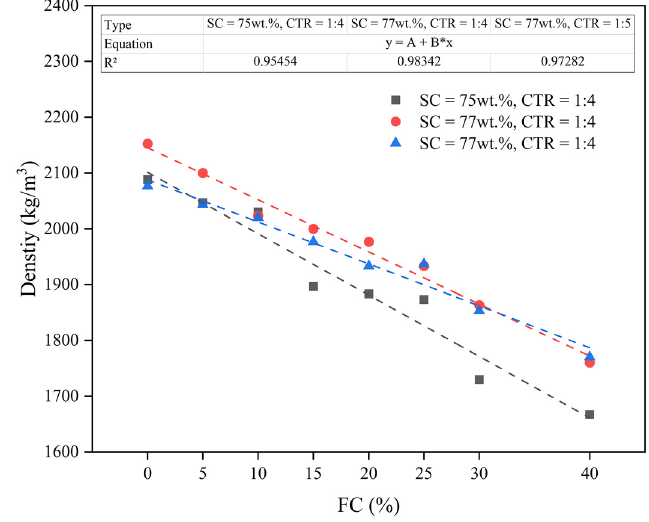
Figure 8. Effect of the FC on the density of the FCPB.